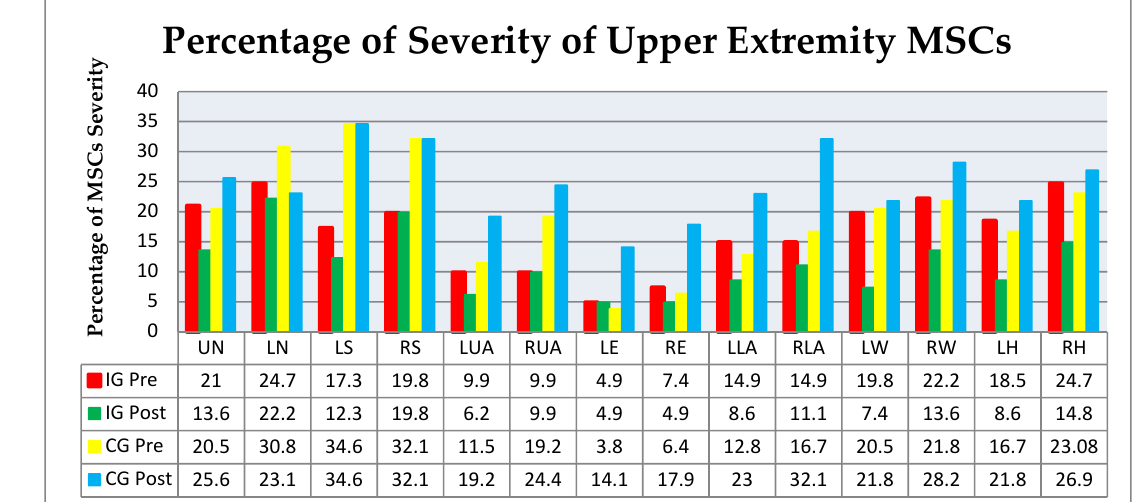
Figure 4. Percentage of upper extremity MSC severity. IG Pre—intervention group before the intervention; IG Post—intervention group after the intervention; CG Pre—control group before the intervention; CG Post—control group after the intervention. Musculoskeletal system: UN (upper neck), LN (lower neck), RS (right shoulder), LS (left shoulder), LUA (left upper arm), RUA (right upper arm), LE (left elbow), RE (right elbow), LLA (left lower arm), RLA (right lower arm), LW (lower wrist), RW (right wrist), LH (left hand), and RH (right hand).